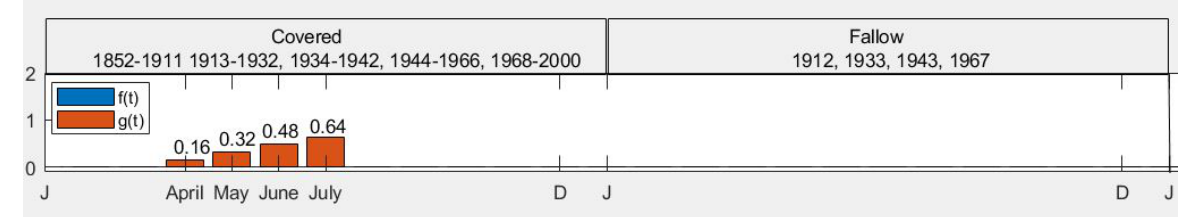
Figure 6. Hoosfield barley experiment. Scenario 1: unmanured treatment.